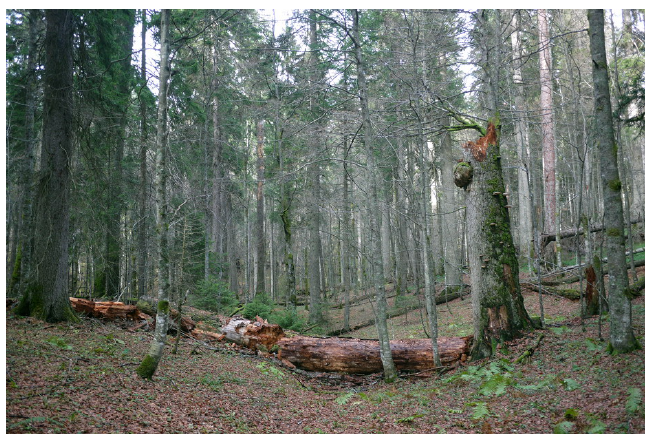
Figure 6. A dense, ubiquitous small tree layer of beech with scattered conifer seedling clusters below is typical for a large part of the Janj reserve (November 1, 2012; photo: J.